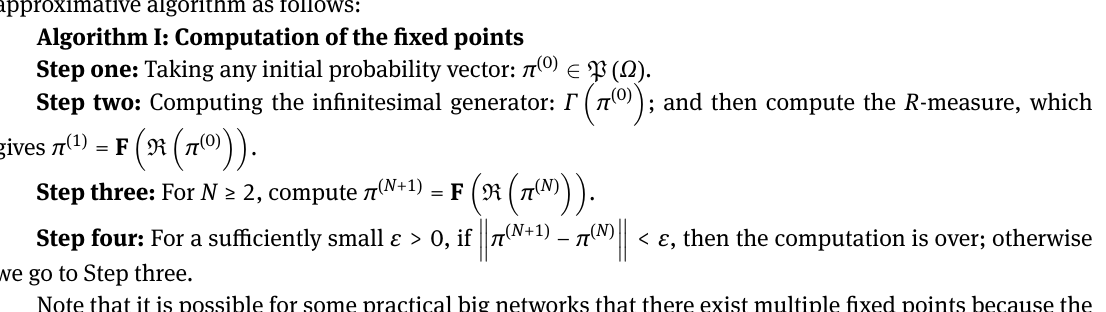
Algorithm I: Computation of the fixed